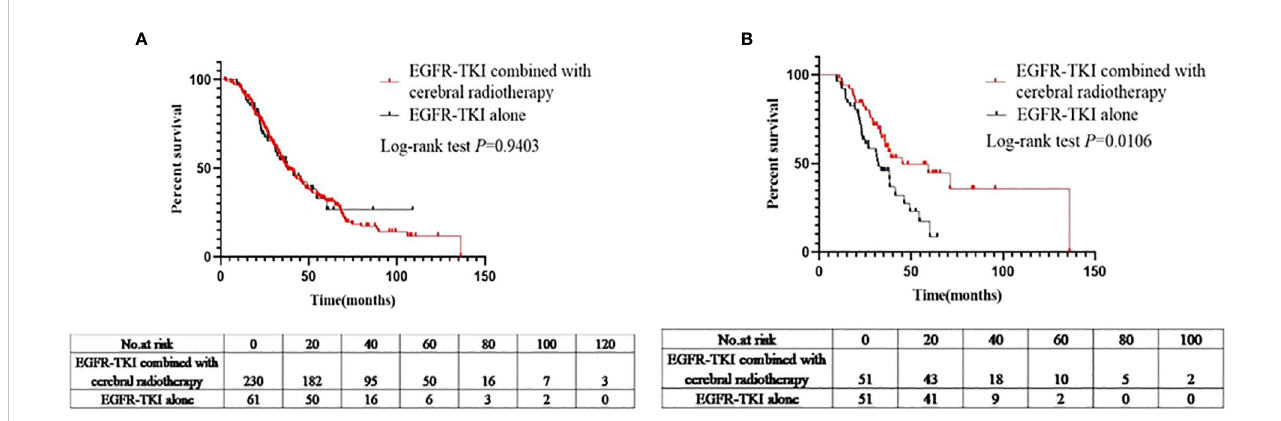
FIGURE 4 (A) Comparison of OS between the EGFR-TKIs combined with cerebral radiotherapy group and EGFR-TKI alone group before PSM. (B) Comparison of OSbetween the EGFR-TKIs combined with cerebral radiotherapy group and EGFR-TKI alone group after